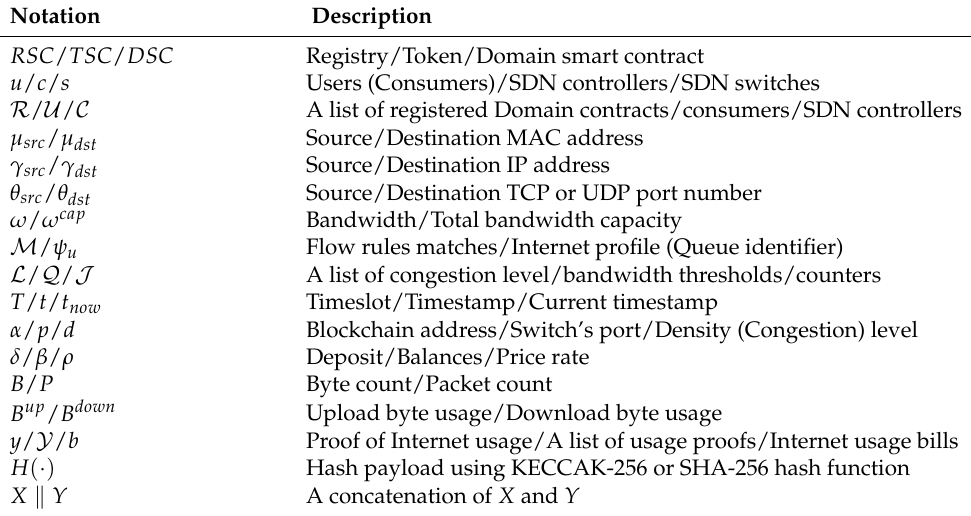
Table 1. List of notations used in this